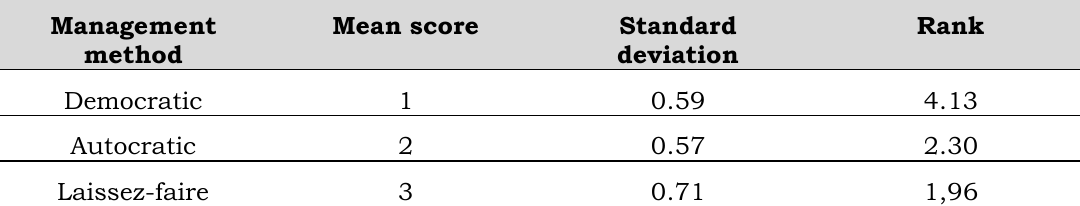
Table 1 . Mean scores, standard deviations, and ranks of the classroom management methods arranged in descending order according to the mean